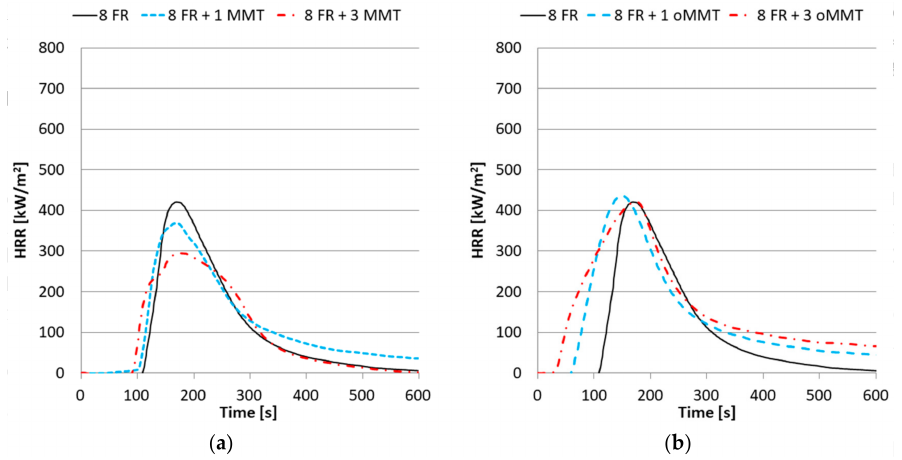
Figure 9. Heat Release Rate curves of nanocomposites with 8% FR ( a ) and MMT filler; ( b ) oMMT filler.